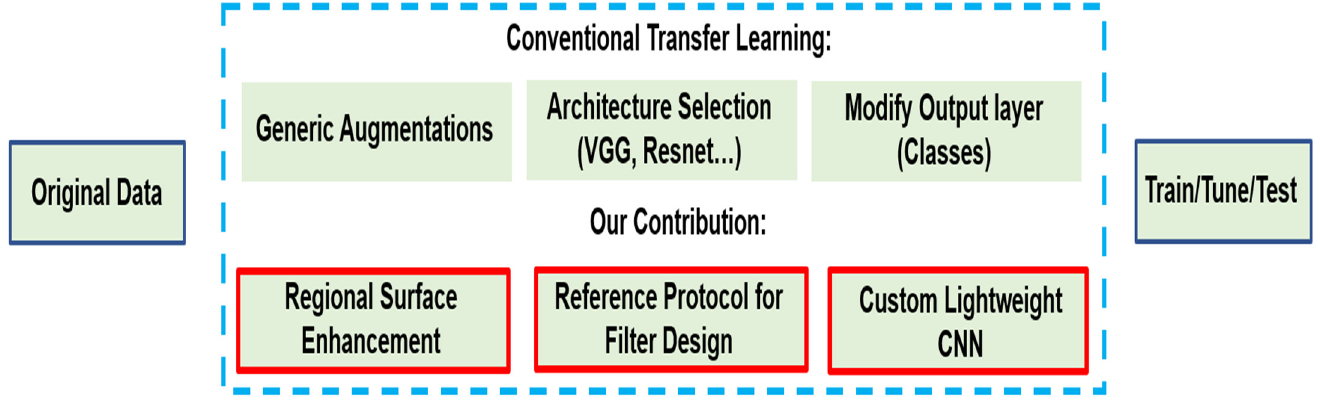
Figure 1. Abstract Solution Comparison.